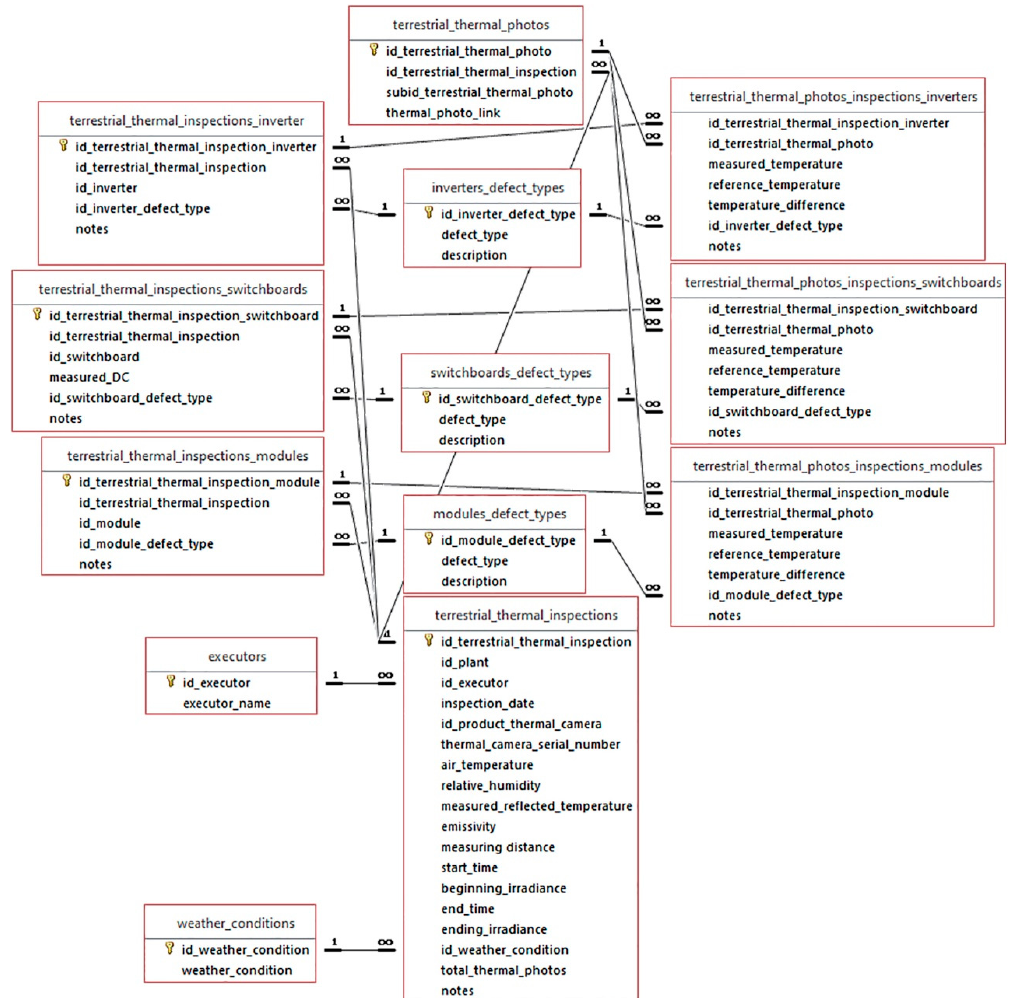
Figure 11. The terrestrial thermal inspections group of the relational database.